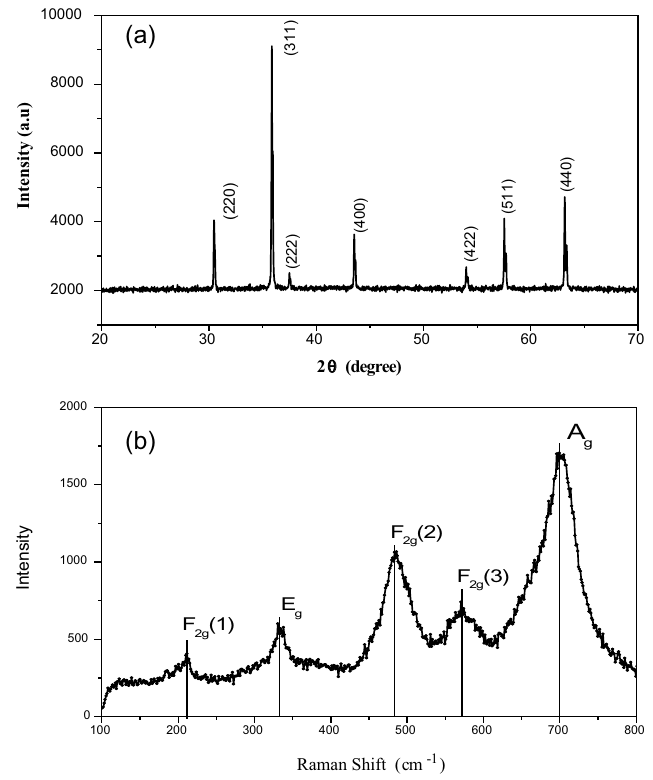
Figure 3. ( a ) XRD pattern of NAFO nanoparticles ( b ) Raman spectra of NAFO